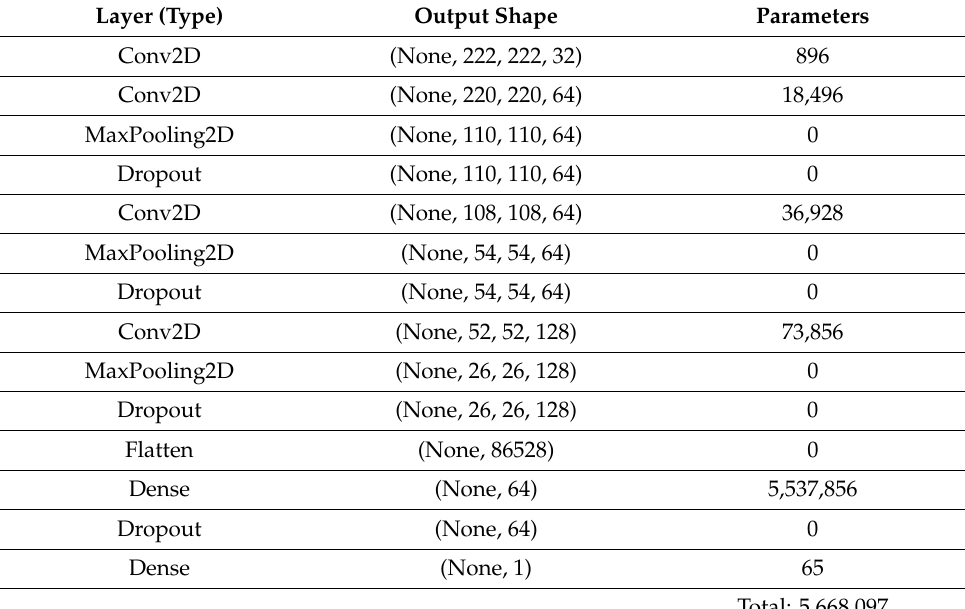
Table 2. Summary of proposed CNN model showing layer names, output shapes and parameters.